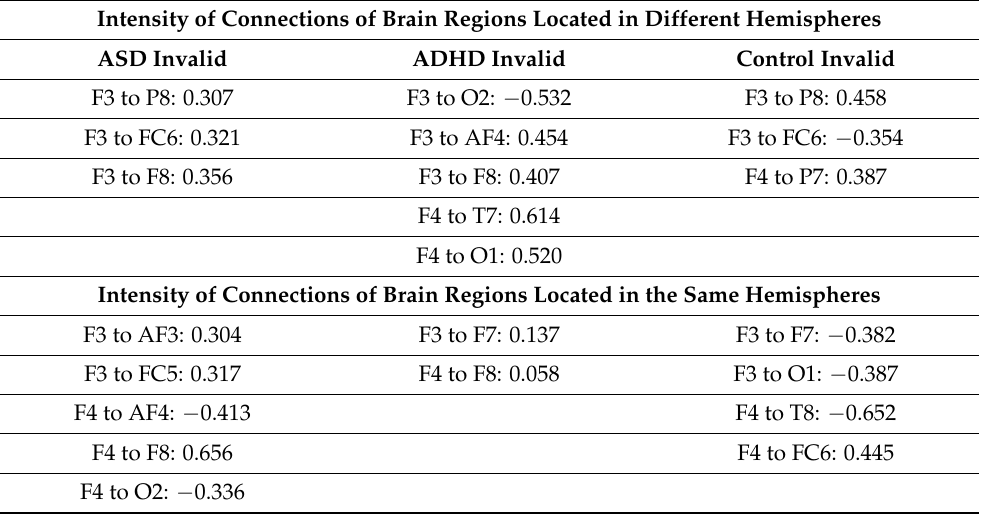
Table 14. Intensity of connections of brain regions located in different and in the same hemispheres for the Invalid